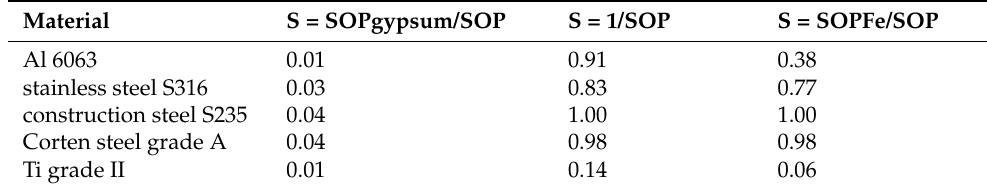
Table 3. The different ways to calculate S from the SOP for the selected